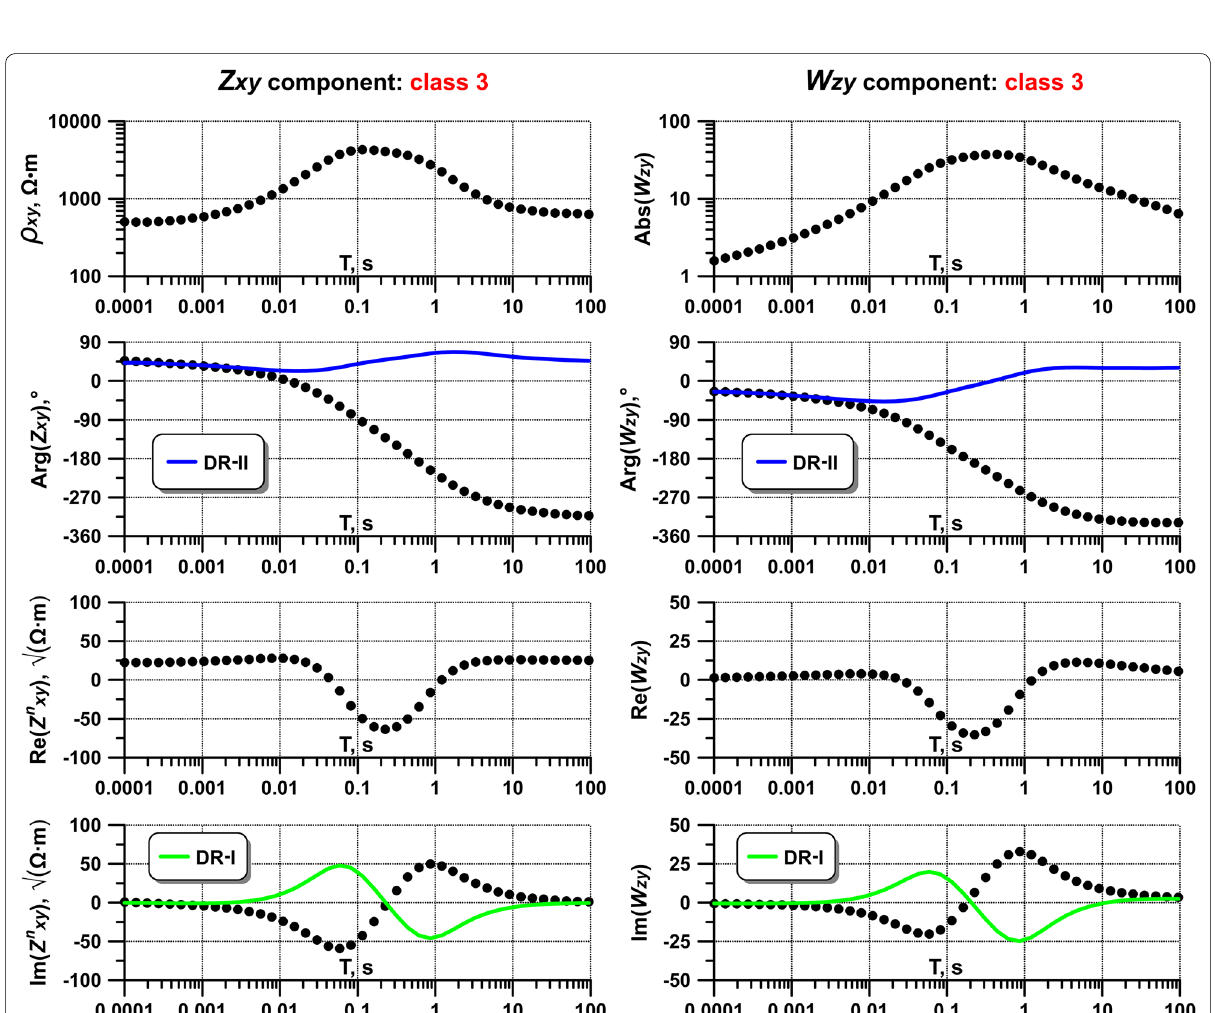
Fig. 5 The DR validity in Z xy and W zy components observed near the 2-D